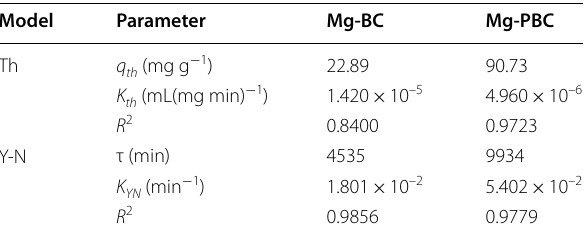
Table 3 Predicted parameters of column P adsorptive recovery